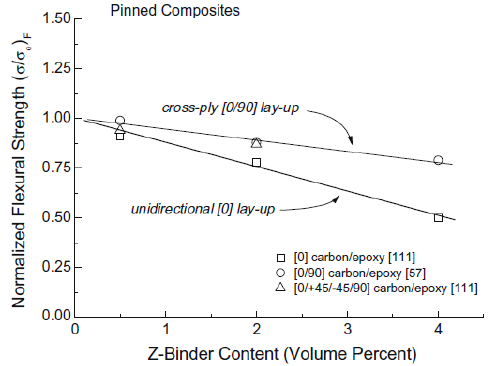
Figure 51. E ff ect of z-Pin content on flexural strength due to z-Pinning on various lay-up laminates (CFRP z-Pins, pre-preg)